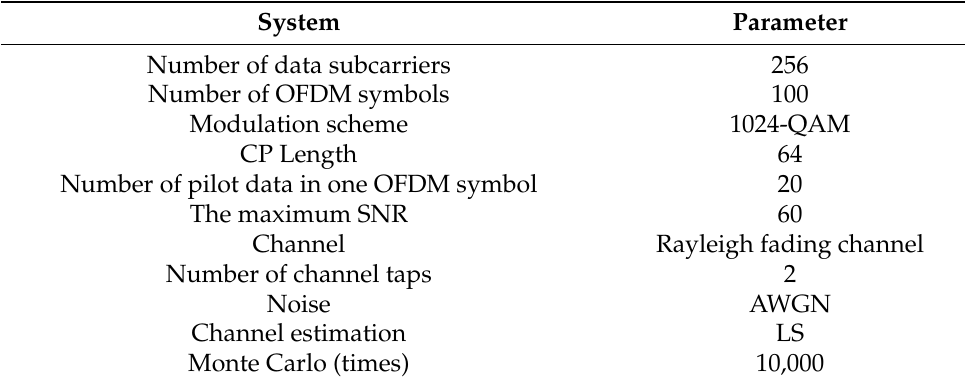
Table 1. Simulation scenarios.